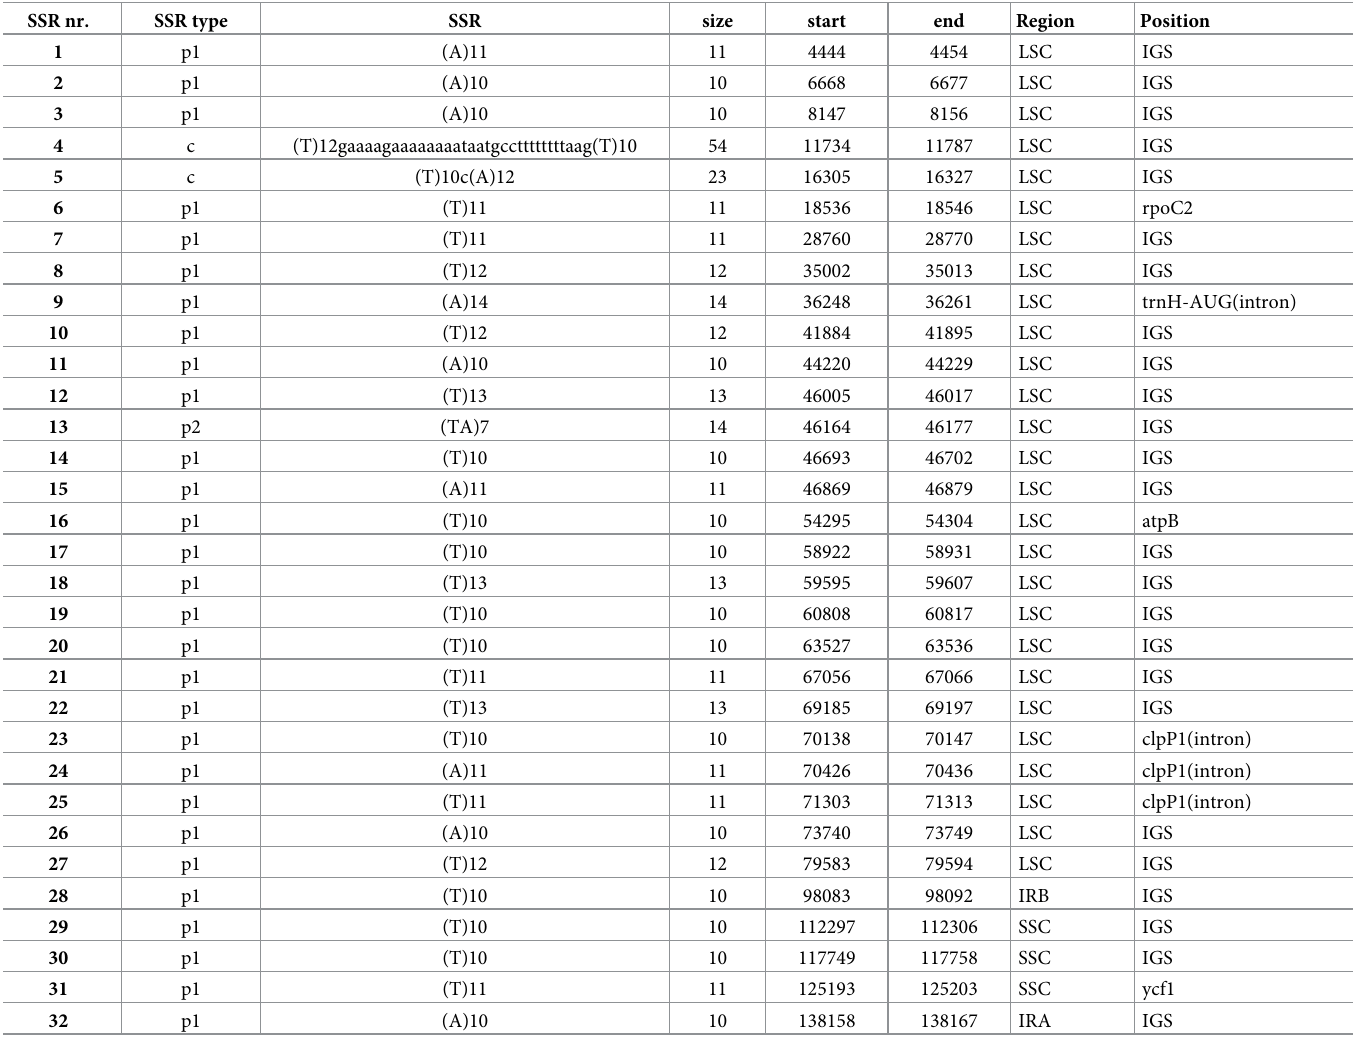
Table 3. SSRs in the chloroplast genome of I . rubescens . SSR